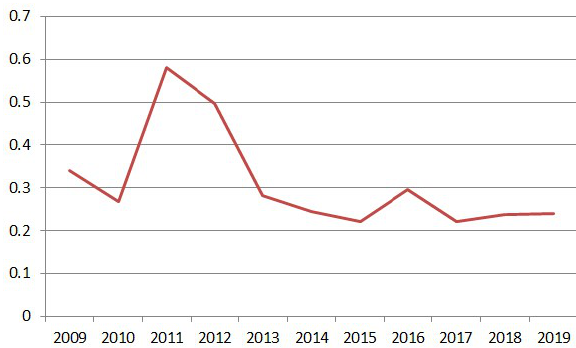
Fig. 2 The increase in the number of tourists in Lanzhou City during